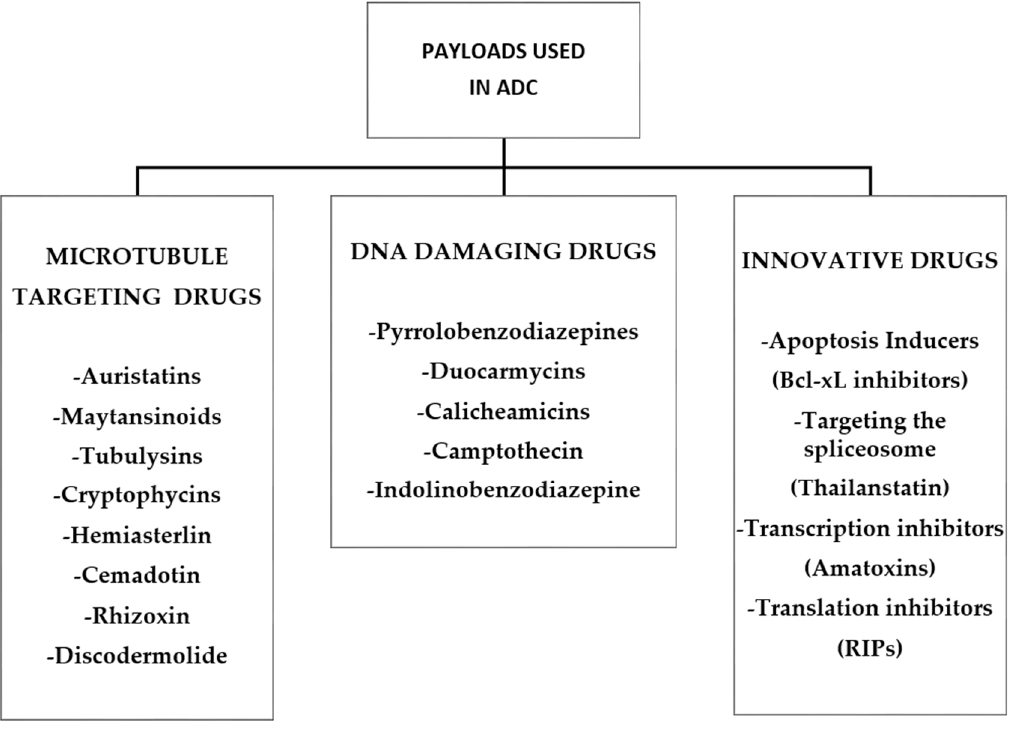
Figure 10. Summary diagram of the different classes of cytotoxic molecules used in ADC construction.